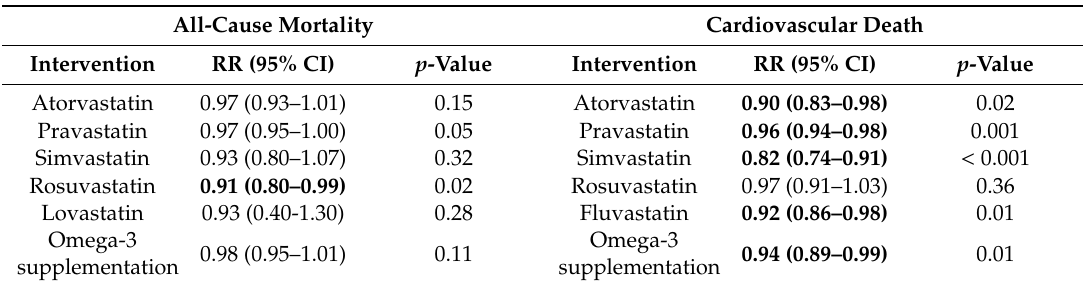
Table A4. Dose–response e ff ects of statins and omega-3 supplementation on all-cause mortality and cardiovascular